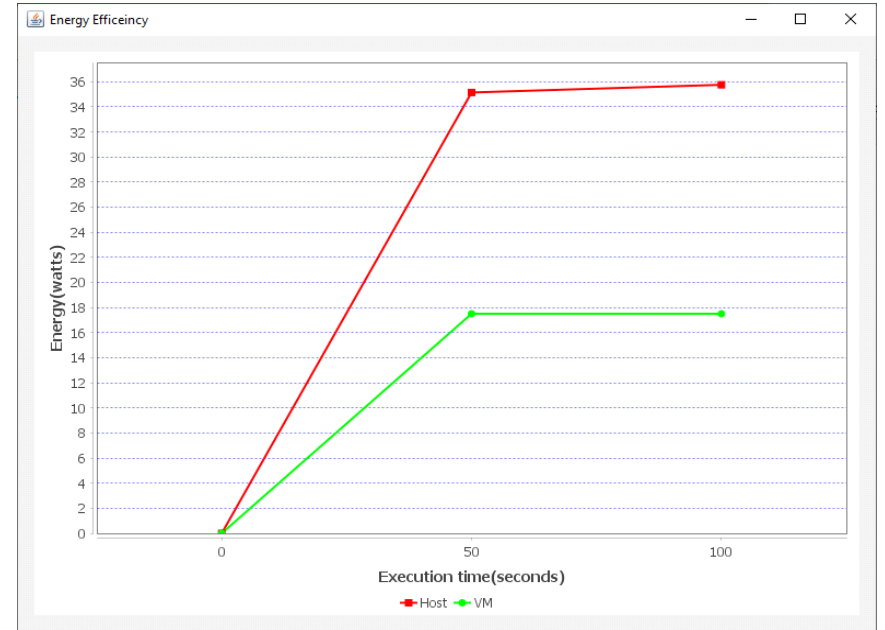
Figure 5. Energy efficiency. Table 3. Energy efficiency values for host and VM.